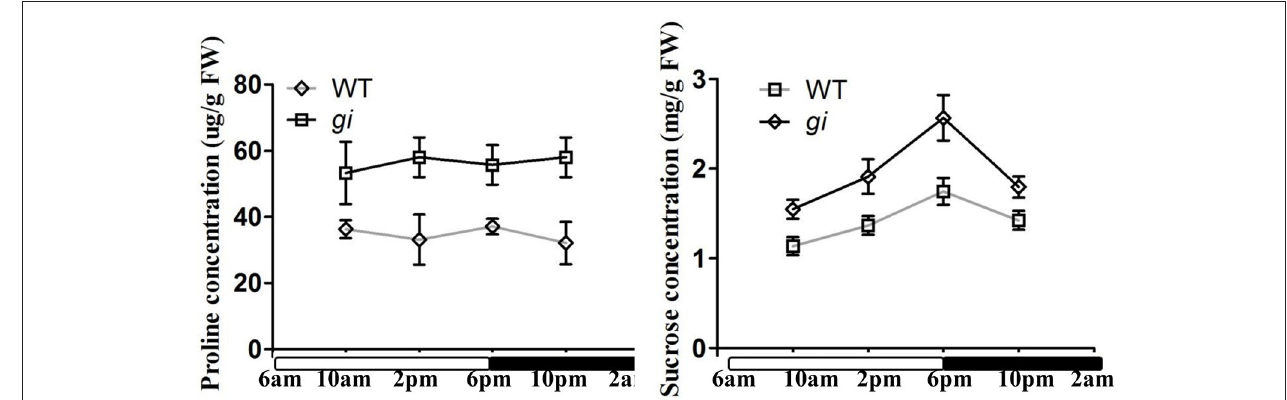
FIGURE 5 | Analysis of proline and sucrose contents in WT and osgi plants. Proline and sucrose contents in leaves of 15-day-old WT and osgi plants grown under normal conditions. All data represent the mean of three biological replicates, with error bars indicating SD. The unfilled and filled bars below the x-axis indicate times of lights-on and lights-off,